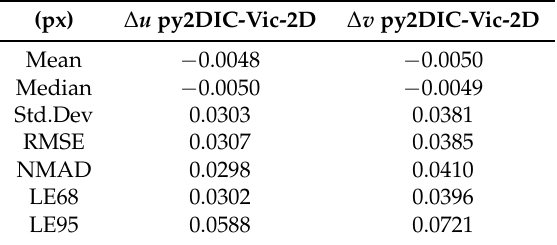
Table 4. Comparison with Vic-2D : statistical parameters of displacement